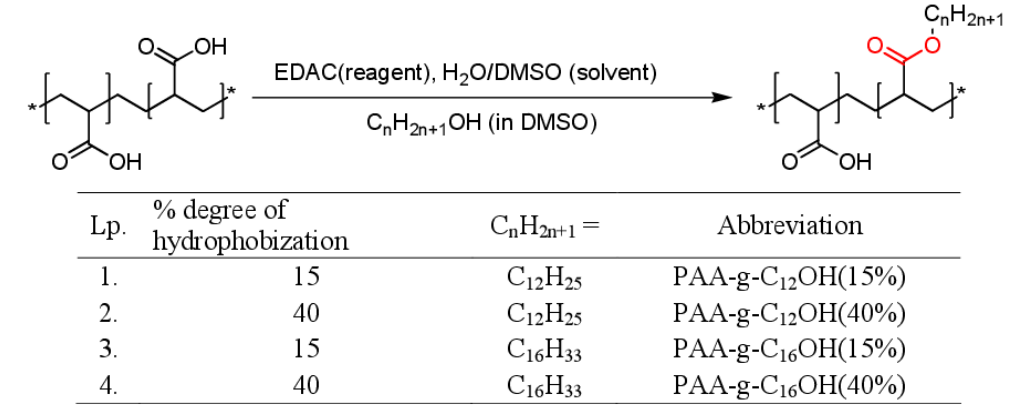
Figure 1. Chemical structure, abbreviations and synthetic route for hydrophobically functionalized poly(acrylic acids) (PAA) comprising the ester bond as a labile moiety. N -Ethyl- N ’-(3-dimethylaminopropyl)carbodiimide hydrochloride (EDAC), dimethyl sulfoxide (DMSO).